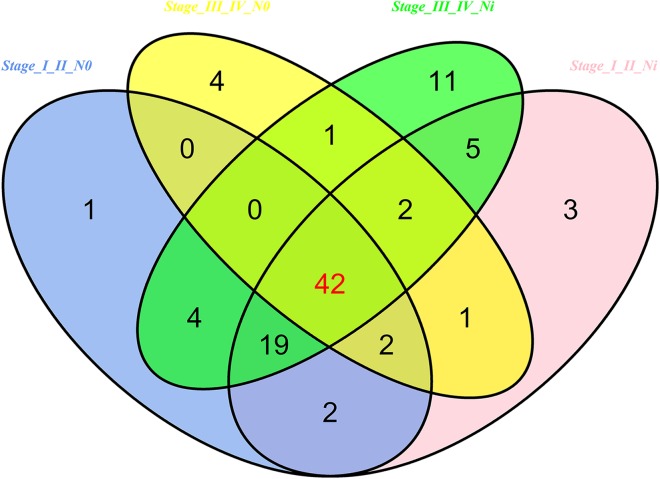
Venn diagram analysis of aberrantly expressed miRNAs between I–II Lymph/N, I–II non-Lym/N, III–IV Lymph/N and III–IV non-Lym/N.Lymph, lymphatic metastasis; non-Lym, non-lymphatic metastasis; N represents adjacent non-tumor lung tissues.